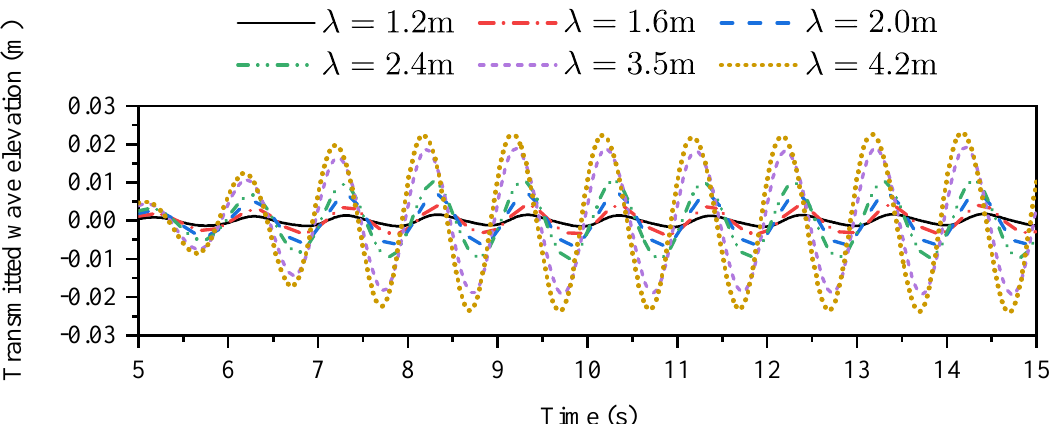
Figure 11. Evolutionary profiles of transmitted wave at gauge G3 by imposing incident waves with different wave lengths.